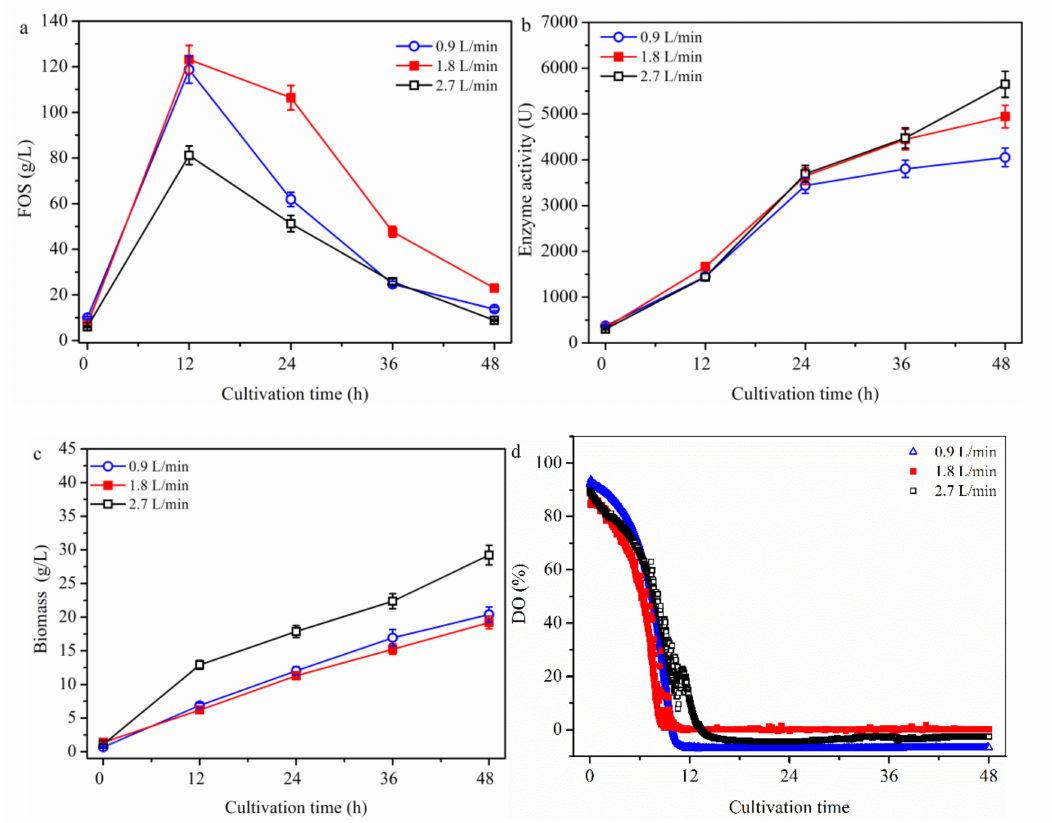
Figure 3. Time profiles of batch cultivation at different aeration rates on FOS production. The A. pullulans ipe-3 strain was cultivated in a 2.7 L bioreactor at pH 5.5 and 25 ◦ C with different aeration rates. The time courses refer to ( a ) FOS, ( b ) enzyme activity, ( c ) biomass, and ( d ) DO. The working volume was 1.8 L. Data are given as the mean ± SD, n =